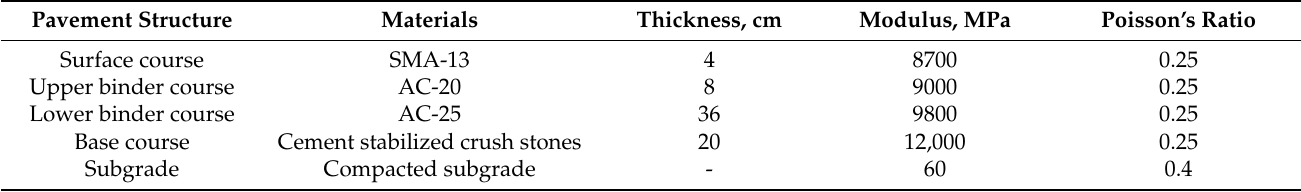
Table 3. Input parameters of the test section for BISAR